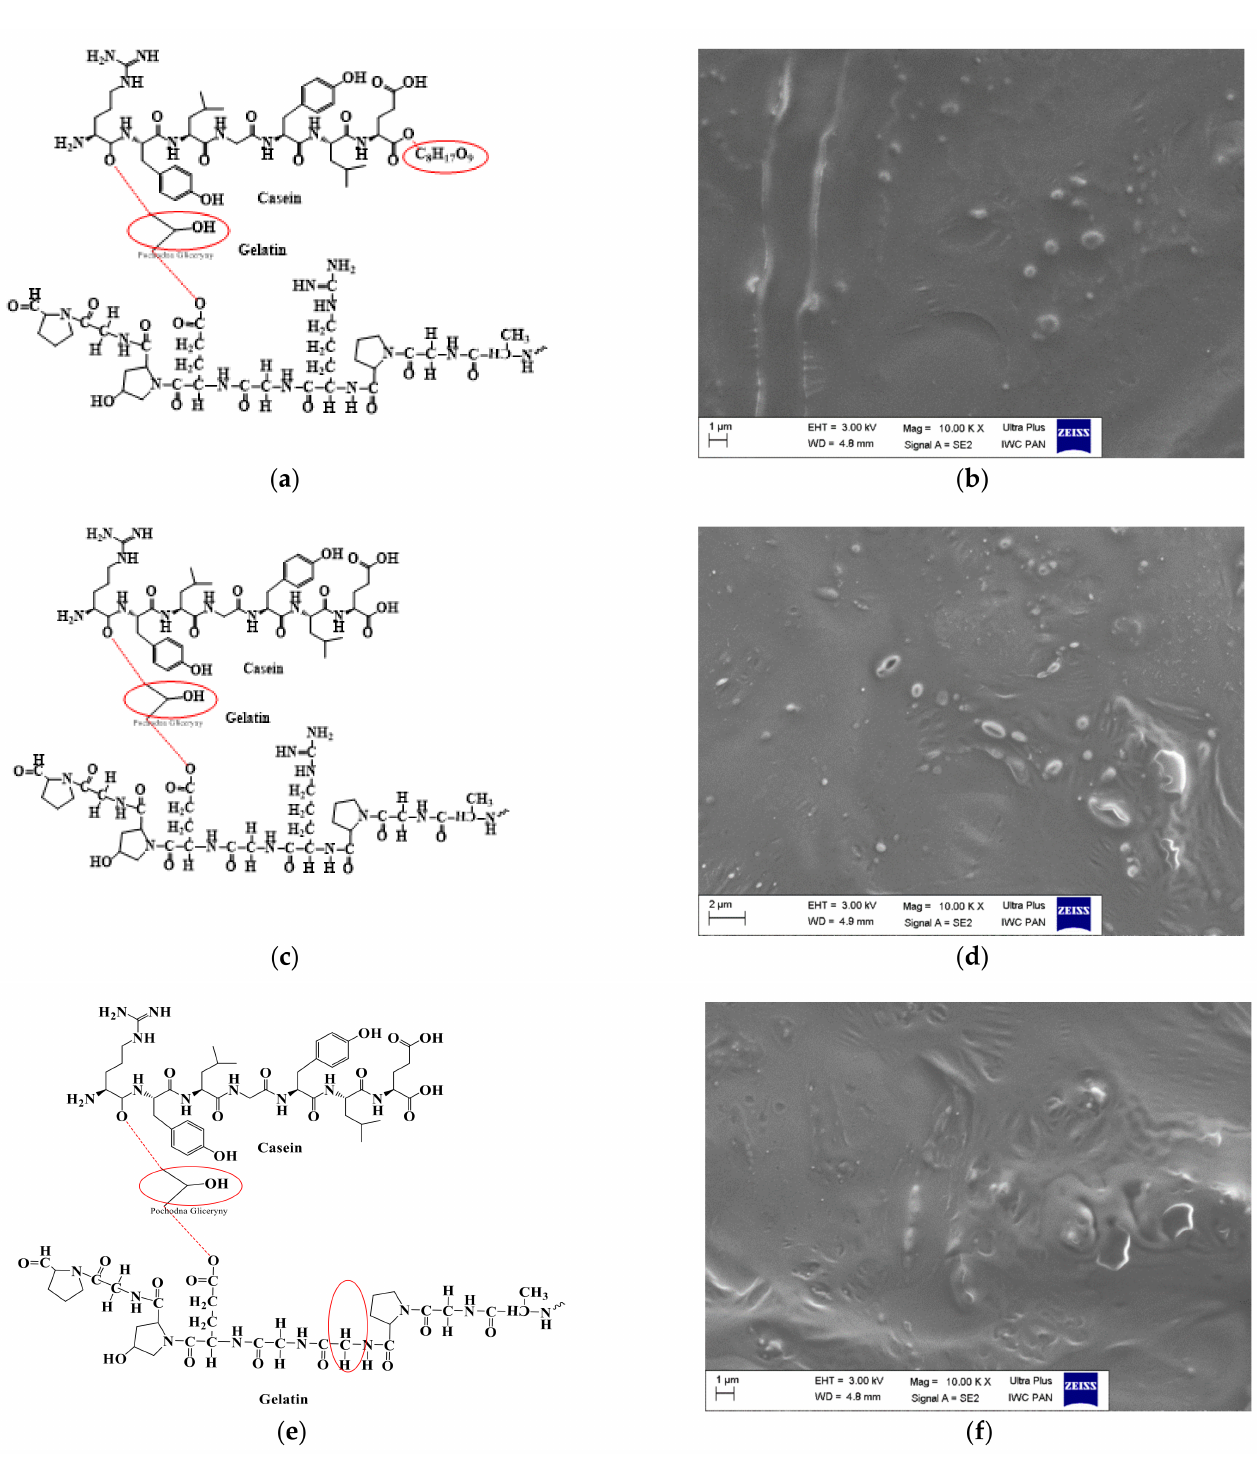
Figure 4. The probable mechanism of interaction ( a , c , e ) for composites H0, HA, HB and. SEM pictures ( b , d , f ) of H0, HA, HB films, mag. 10,000 ×